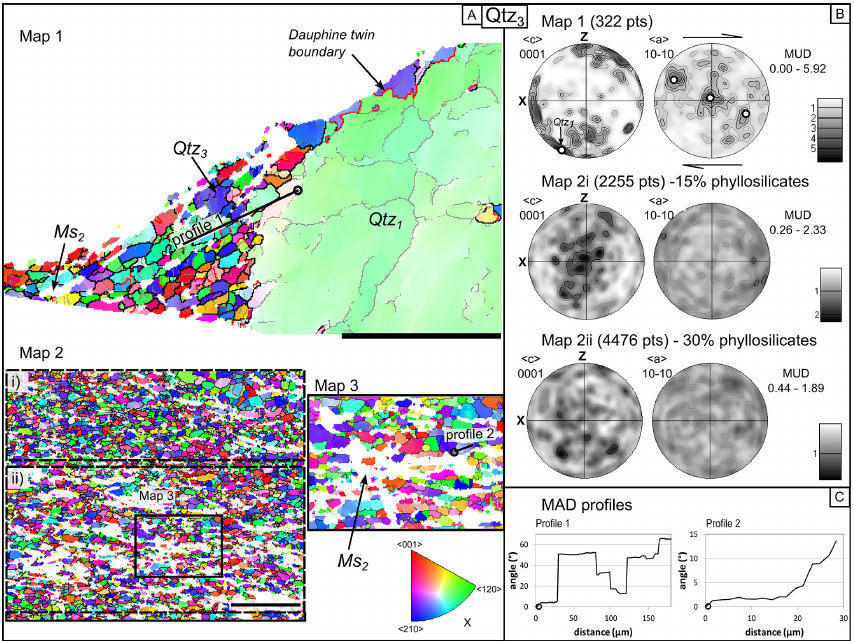
Figure 9. (a) GB (grain boundary) + IPF (inverse pole figure) map of Qtz 3 microstructures in phyllonites (acquisition locations marked in Figs. 5a, 6b). Map 2 is separated in two areas for pole figure plots. Area (i) represents quartz-rich part (15% muscovite), while area (ii) has large muscovite mode (30% muscovite). Map 3 is an enlarged image from map 2b, showing subgrain-scale microstructures; scale bars are 200µm long. (b) Pole figures of the crystallographic orientation data for map 2(i) and map 2(ii), plotted as one point per grain using equal-area projection and the upper hemisphere. The white dot in the pole figure for map 1 marks the orientation of the Qtz 1 grain, which occurs at the central part of Qtz 2 domain. (c) Misorientation profiles across two selected regions in map 1 and map 3, where the profiles are marked by black lines and the circle represents starting position.